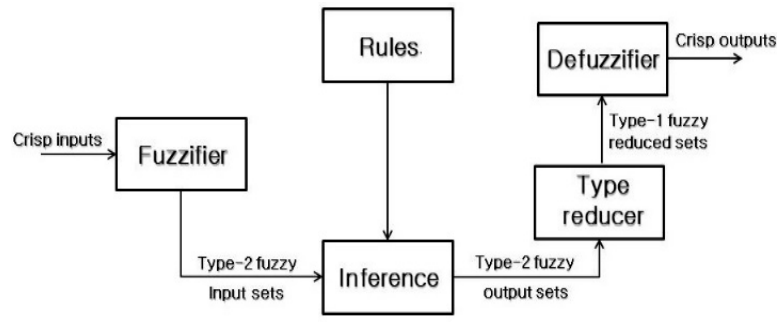
Figure 10. Structure of the type-2 fuzzy logic system.